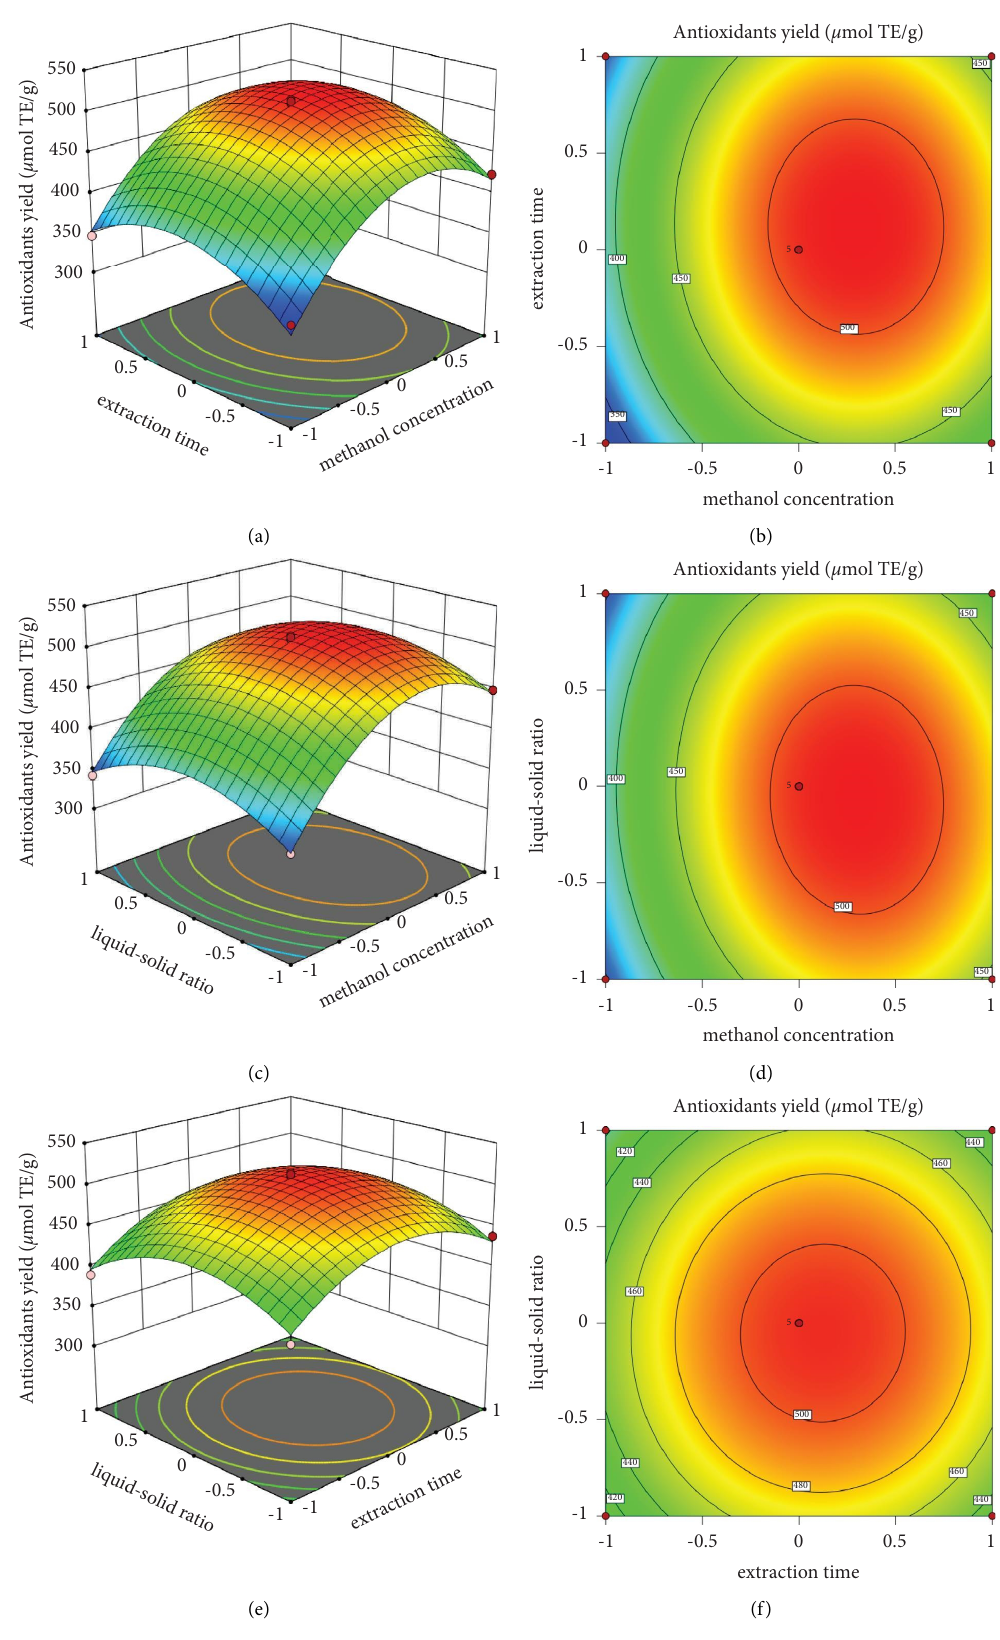
Figure 2: Response surface showing the efect of methanol concentration, extraction time, and liquid-solid ratio on the response Y (antioxidants